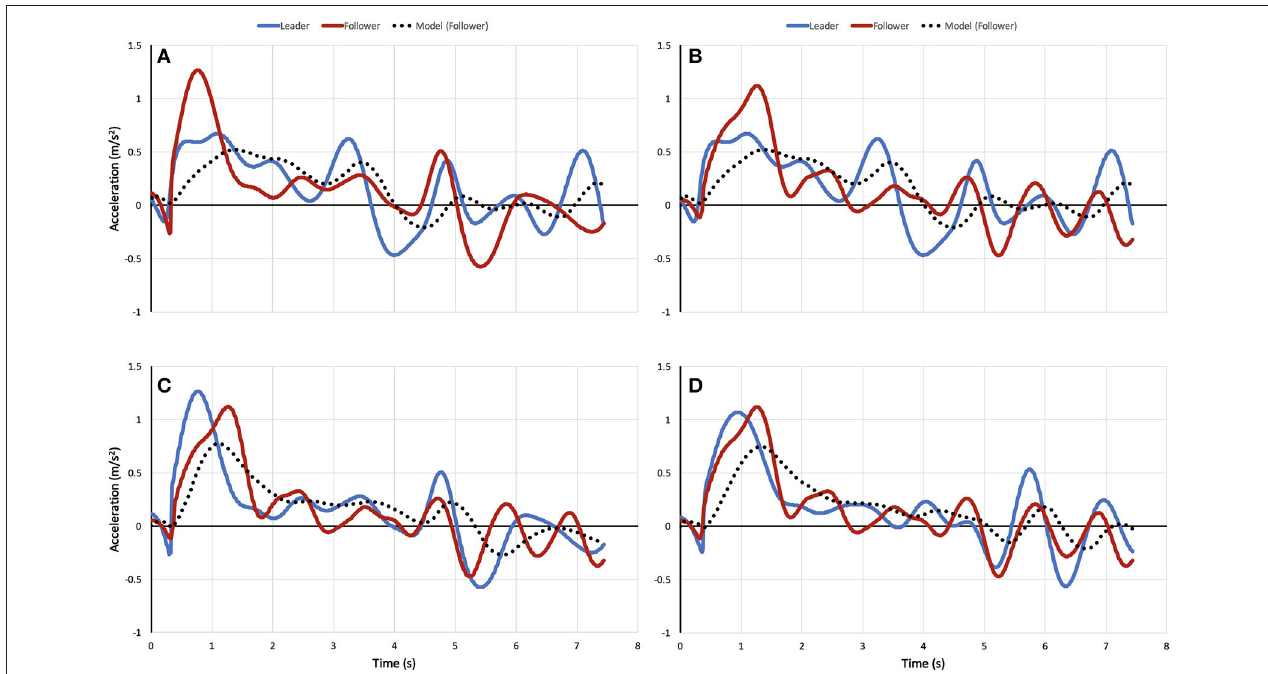
FIGURE 9 | Sample time series of the simulated and observed “follower” acceleration (both in red), together with the observed “leader” acceleration (in blue), for front side-to-side (A) , leader-follower diagonal (B) , leader-follower (C) , and back side-to-side (D)